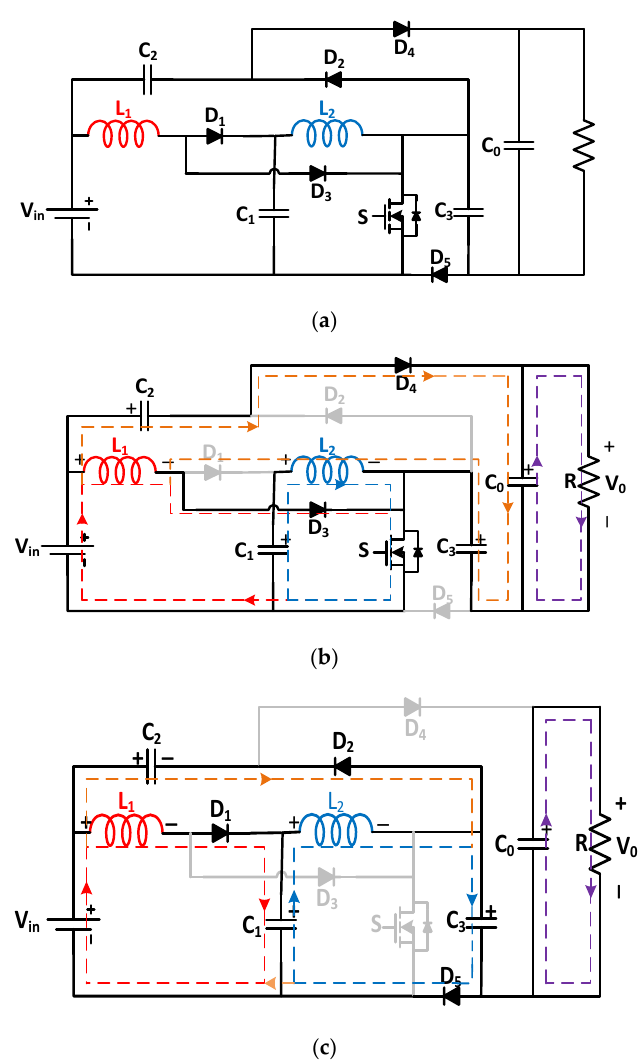
Figure 1. ( a ) Proposed converter I and operating modes of the converter: ( b ) Mode I and ( c ) Mode II.